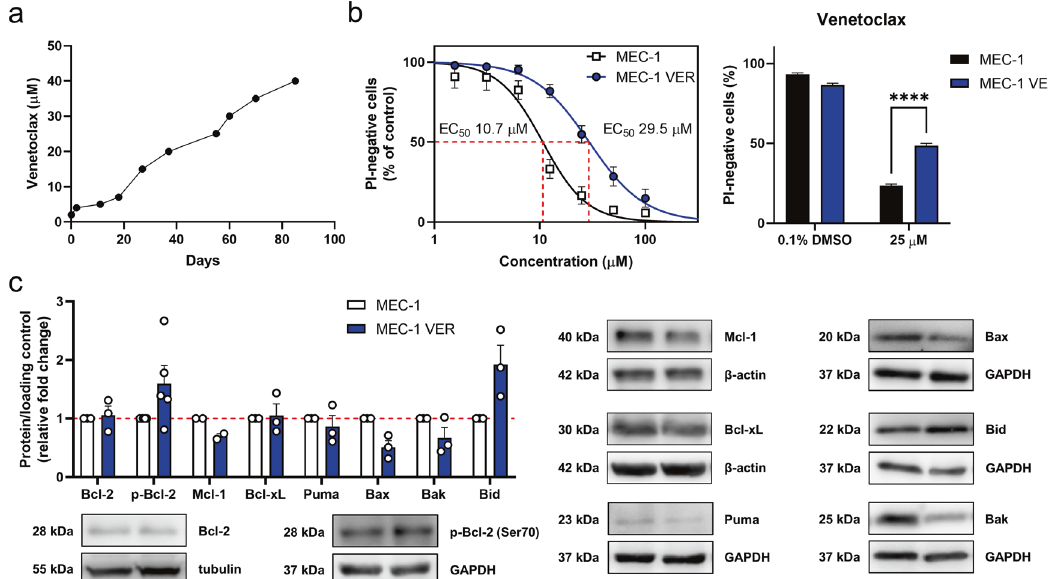
Fig. 3 Establishment of venetoclax-resistant MEC-1 VER cells. a Dosing regimen used for the selection of venetoclax-resistant clones. MEC-1 cells (1 × 10 6 cells/mL) were seeded into a 12 well plate and incubated with gradually increasing concentrations of venetoclax, from 1 µM at day 0, to 40 µM at day 85; b Cytotoxicity of venetoclax in MEC-1 and MEC-1 VER cells. The cells (3 × 10 5 cells/mL) were treated with 0.1% DMSO (vehicle control) and venetoclax (1 – 100 µM) for 24 h. Afterward, 5 µM PI was added and the viability of cells was determined using fl ow cytometry. EC 50 values were calculated using GraphPad Prism 9.2.0 (left). The viabilities of these MEC-1 and MEC-1 VER cells upon treatment with 25 µM venetoclax for 24 h are also shown (right). Data are means ± SEM of three independent experiments, each carried out in duplicate. Statistical signi fi cance was determined using paired Student t-test; **** denotes p < 0.0001; c Expression of anti-apoptotic proteins in MEC-1 and MEC-1 VER cells. Whole-cell lysates of MEC-1 and MEC-1 VER cells, cultured under basal conditions, were probed for Bcl-2, p-Bcl-2 (Ser70), Mcl-1, Bcl-xL, Puma, Bax, Bak, and Bid levels using immunoblotting. Data are means ± SEM of three independent experiments. Representative immunoblots are also